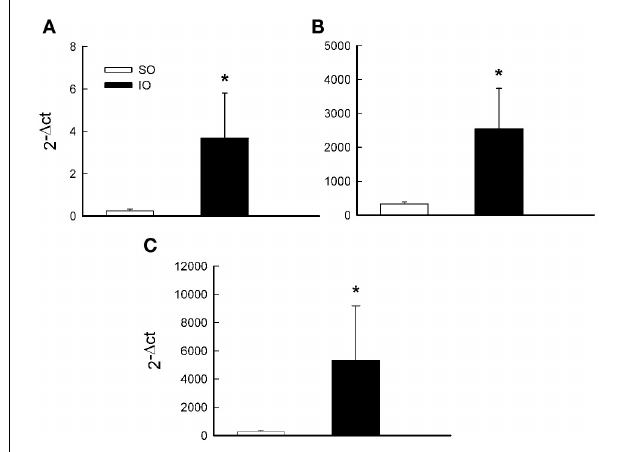
FIGURE 6 | Comparative analysis of mRNA levels of the NAD(P)H-oxidase subunit Nox-1 (A), p22 phox (B), and p47 phox (C) from SO and IO rats. mRNA levels are expressed as 2 − Δ ct using 18S as internal control. Data are the mean ± SEM of n = 6–7. * P < 0.05 by unpaired Student’s t